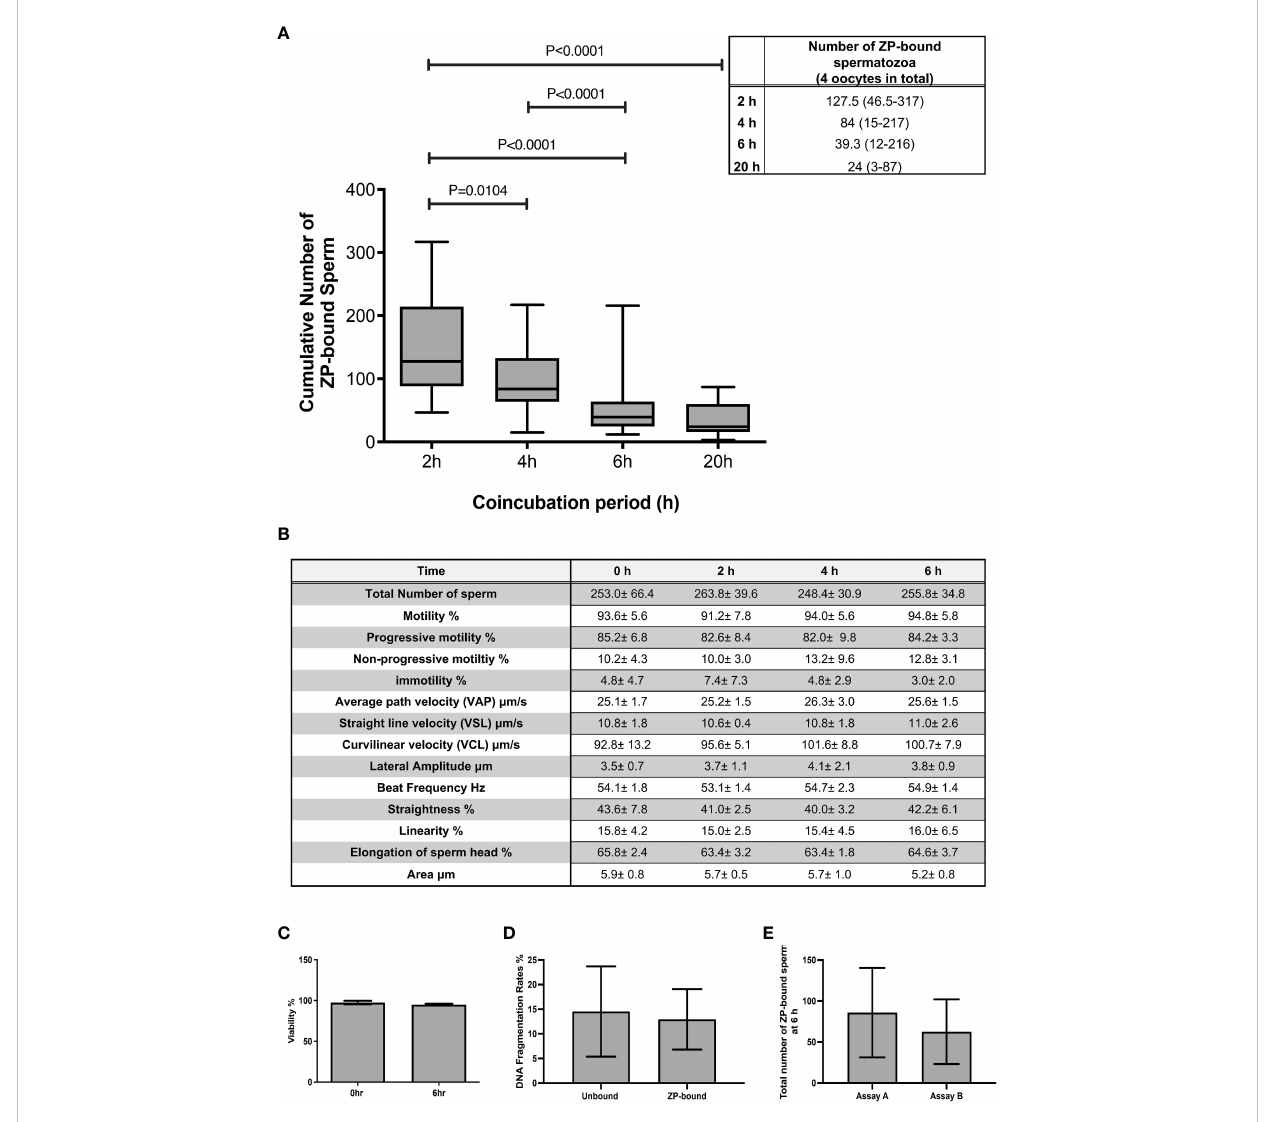
FIGURE 1 The total number of ZP-bound spermatozoa over the 6-h and 20-h incubation. (A) The number of spermatozoa tightly bound to the oocytes was counted at 2 h intervals during the 6-h incubation. There was a large variation in the number of ZP-bound spermatozoa, but the decreasing trend persisted in all samples. All data are represented as median (range) (n=24 for 6-h; n=6 for 20-h, p<0.05). (B) Effects of prolonged incubation on sperm motility at intervals of 0, 2, 4, 6 h. (C, D) Effects of prolonged incubation on sperm viability and DNA integrity at 0 and 6 hr. (E) The total number of ZP-bound spermatozoa with (Assay A) /without (Assay B) the replacement of fresh oocytes at 4 hr. All data are represented as mean ± SD